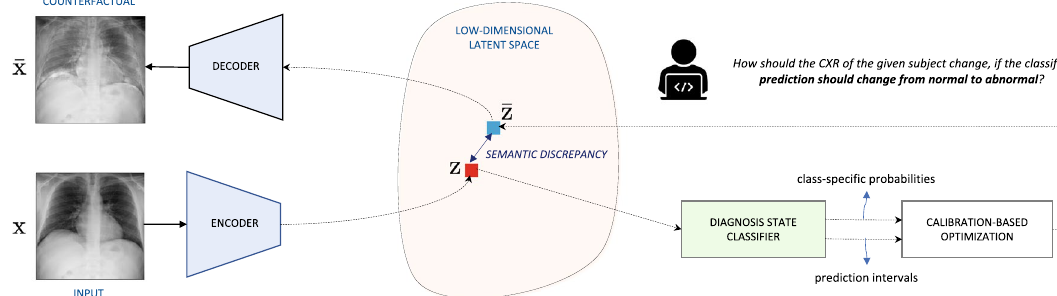
Figure 1. An overview of TraCE applied for introspective analysis of chest X-ray (CXR)-based predictive models. In this example, we consider a binary classifier that has been trained to distinguish between normal and abnormal subjects (i.e., containing pneumonia-related anomalies). Since TraCE carries out the optimization in the latent space of a pre-trained auto-encoder model, we first transform a query image x (from the normal class) into its latent representation Z using the Encoder . Subsequently, we invoke the proposed